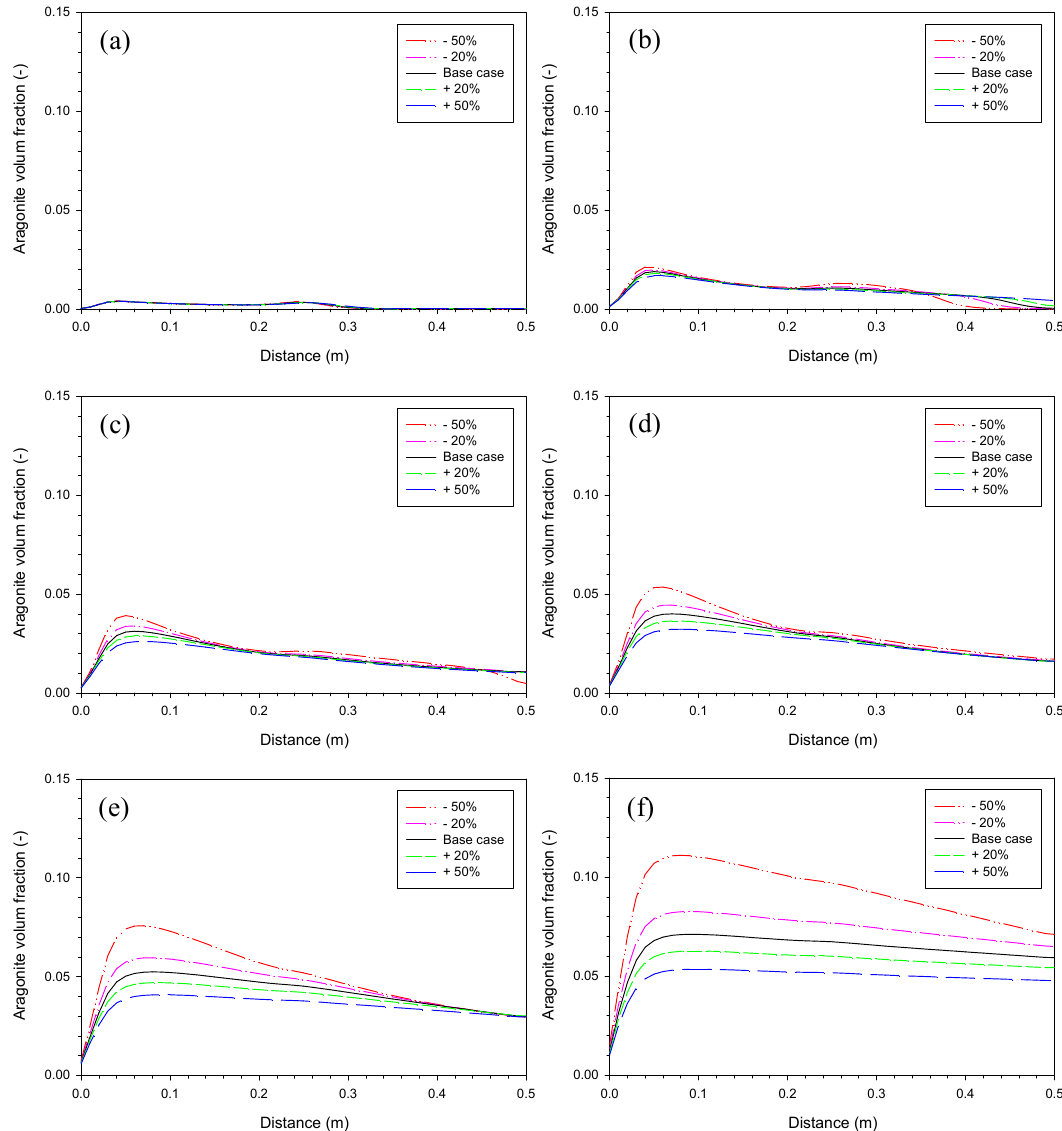
Figure 8. Sensitivity analysis of α 1 (proportionality constant for aragonite). Aragonite volume fraction on ( a ) Day 4, ( b ) Day 25, ( c ) Day 54, ( d ) Day 87, ( e ) Day 164, and ( f ) Day 410 with value of the base case, +/−20% and +/−50%.